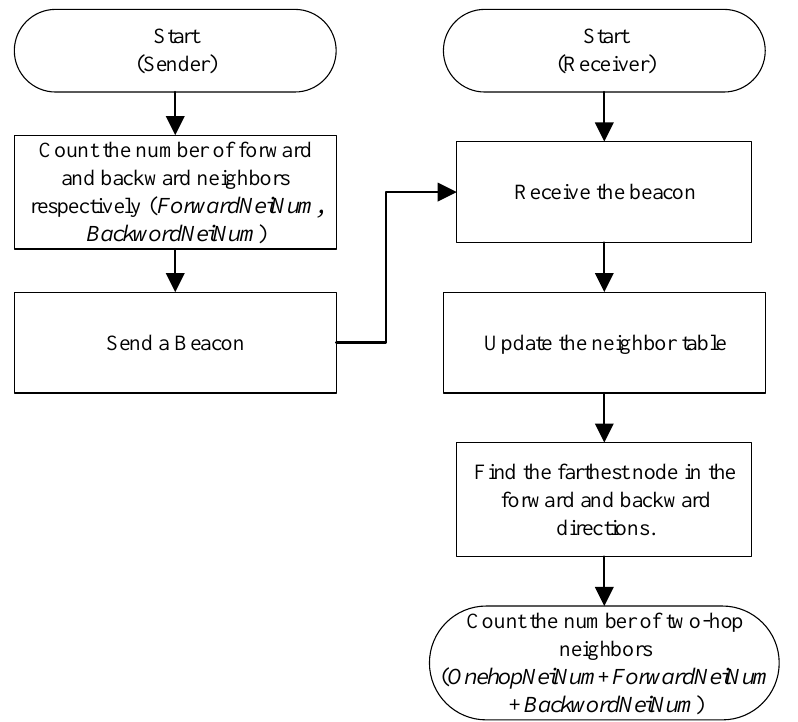
Figure 6. Two-hop neighbors number calculation.